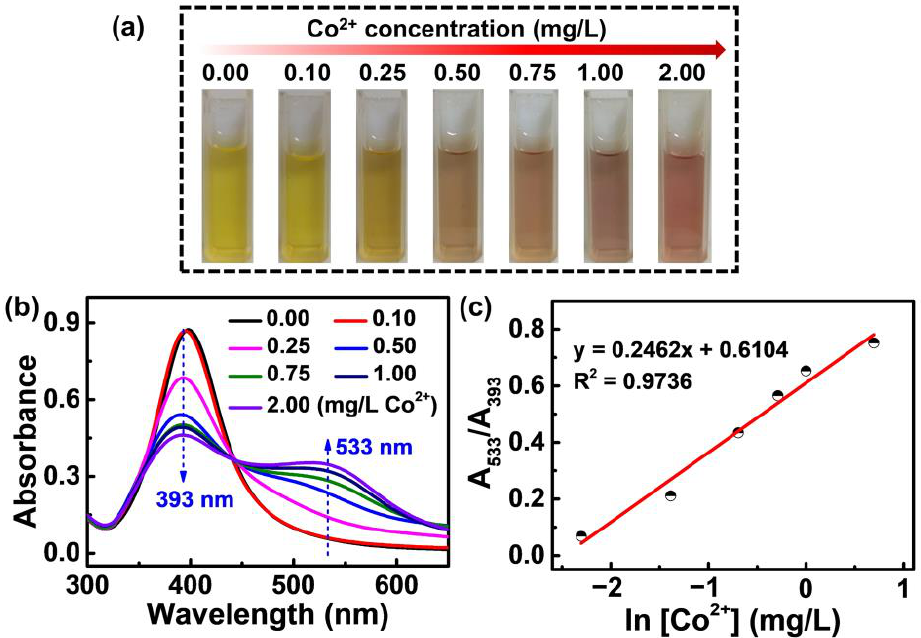
Figure 1. ( a ) Photographic images of PVP-AgNPs sensing solutions with various Co 2+ concentrations (0.00, 0.10, 0.25, 0.50, 0.75, 1.00, 2.00 mg/L). ( b ) The corresponding absorption spectra of ( a ). ( c ) Plot of A 533 /A 393 for PVP-AgNPs experienced with different concentrations of Co 2+ . Discouragingly, addition of Zn 2+ leads to a shocking change in both the color and the UV-vis signals of the solution, meaning a devastating influence on the PVP-AgNPs in terms of sensing the trace Co 2+ . As shown in Figure 2a, addition of Co 2+ into the PVP-AgNPs suspension turns the color from light yellow to light purple. However, co-addition of Co 2+ and Zn 2+ results in the disappearance of the purple color, being replaced with the orange (Co 2 Zn 1K , namely the solution containing 2 mg/L Co 2+ and 1 g/L Zn 2+ ) or dark yellow (Co 2 Zn 50K , namely the solution containing 2 mg/L Co 2+ and 50 g/L Zn 2+ ) images.